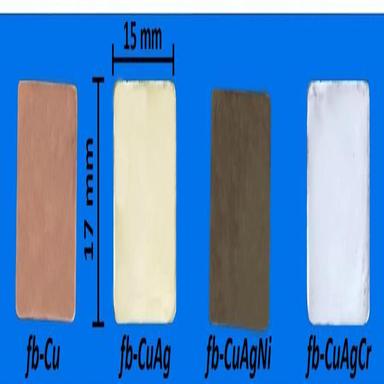
Macro-photographs of the bulk samples produced in this study.